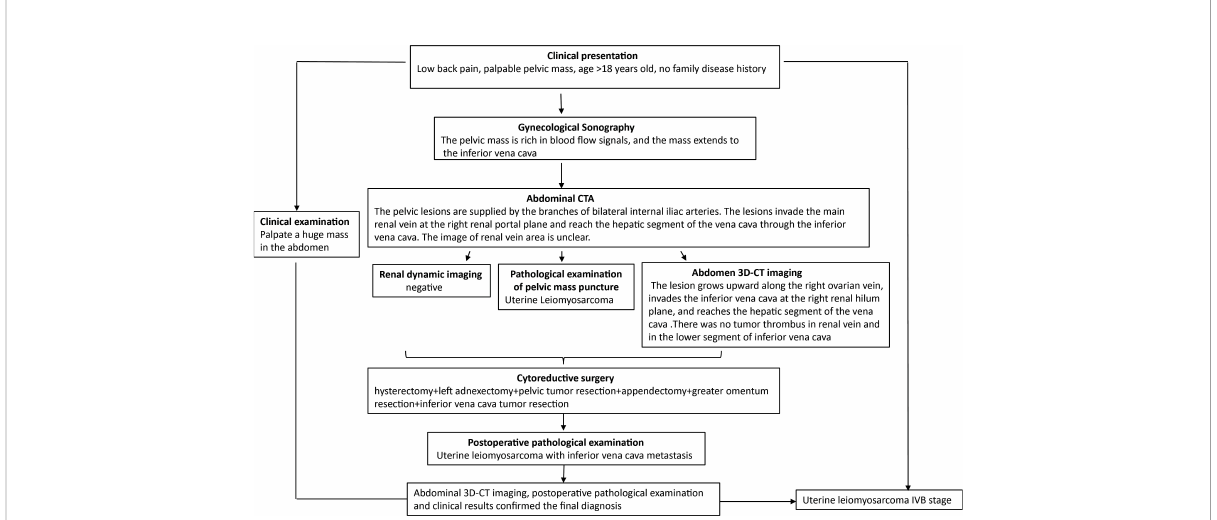
FIGURE 4 Diagnostic work fl ow diagram. The clinical manifestations of abdominal and low back pain must be differentiated from various age-related urinary system diseases. The patient underwent clinical examination, gynecological Doppler ultrasound, abdominal CTA, pelvic mass puncture biopsy (HE, IHC), and abdominal CT 3D imaging. Preoperative abdominal CT 3D imaging made the clear scope of the lesion, the tumor was completely removed during the operation, and the fi nal diagnosis was made by postoperative examination.